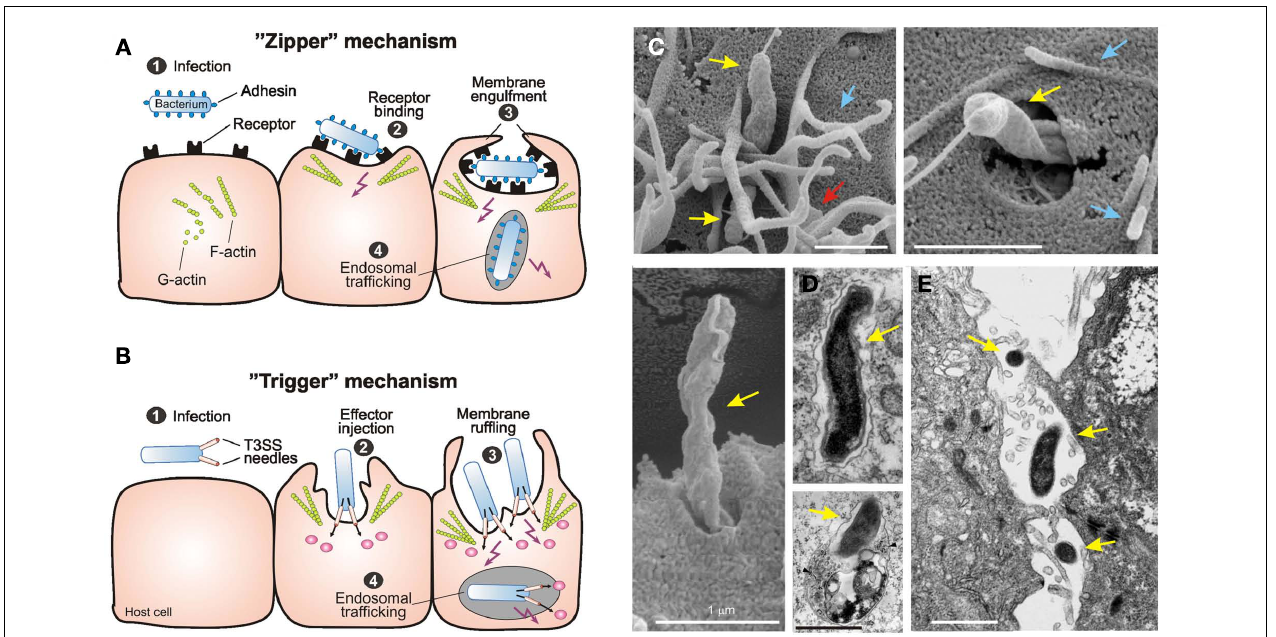
These factors manipulate a variety of signaling events including the activation of small Rho GTPases and cytoskeletal reorganization to induce membrane ruffling and subsequently bacterial uptake [step 3]. As a consequence of this signaling, the bacteria are internalized into a vacuole [step 4], followed by the induction of different signaling pathways for intracellular survival and trafficking.This figure was adapted fromTegtmeyer et al. (2011) with kind permission from Springer Publishing. (C) Scanning electron microscopy of C. jejuni 81-176 invasion. Invading bacteria (yellow arrows) were regularly associated with membrane ruffles (red arrows) and filopodia-like structures (blue arrows).This figure was adapted from Boehm et al. (2012). (D) Electron micrographs of C. jejuni –containing vacuoles (CCVs) that do not co-localize with BSA-gold (left) and CCVs that co-localize with BSA-Gold and resemble lysosomes (right, arrows) are shown.The two pictures were kindly provided by Dr. Galan (Watson and Galán, 2008). (E) The electron micrograph of translocating C. jejuni across polarized Caco-2 cells by the paracellular pathway was kindly provided by Dr. Konkel (Konkel et al.,